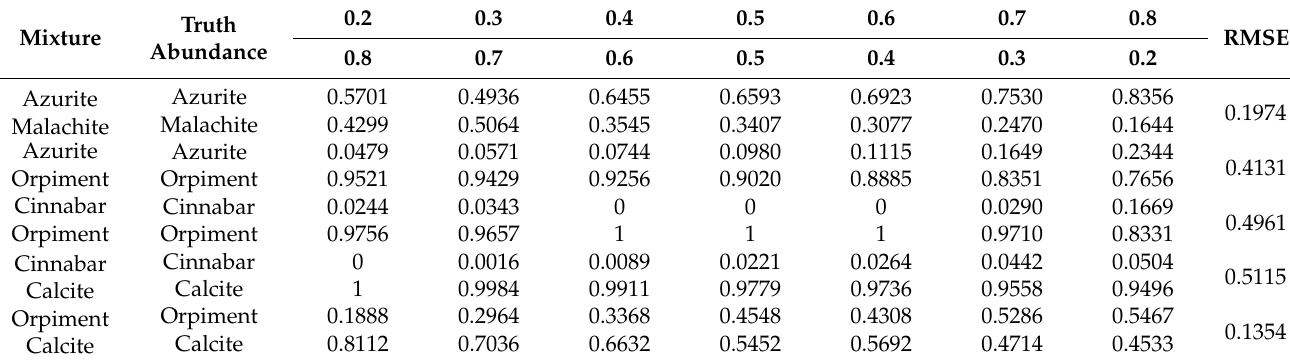
Table 10. Abundance estimated by the K-M theory for five groups of mixed pigment